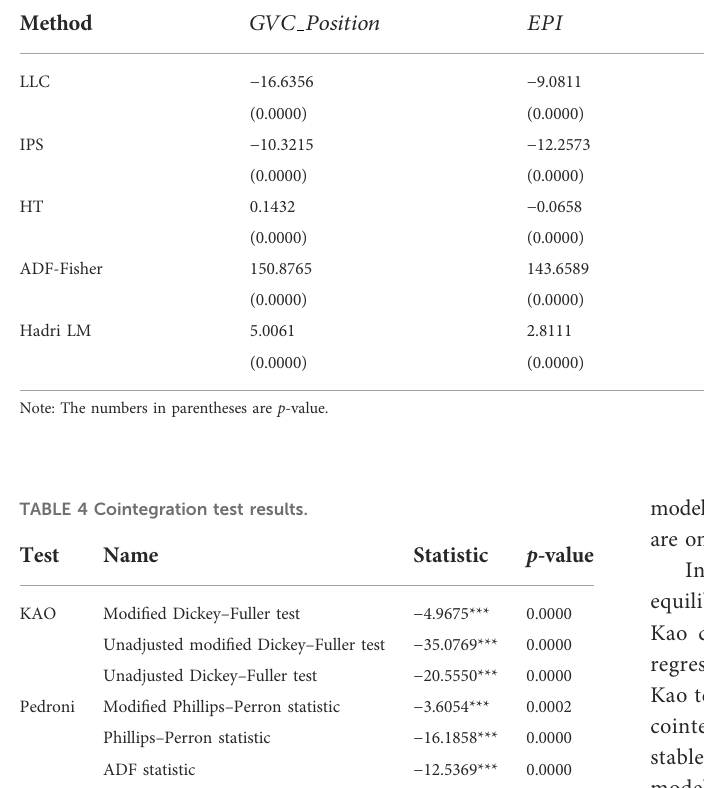
TABLE 3 Results of unit root test for primary variables.